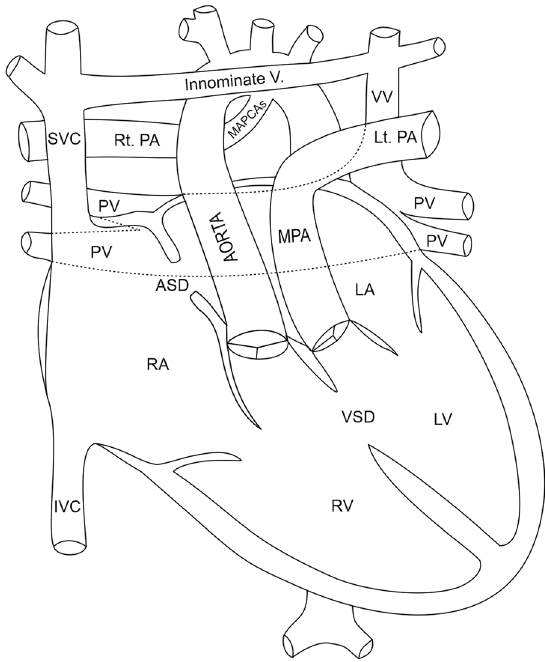
Fig. 3 Schematic of complex cardiac abnormalities of the reported case with the main feature of co-occurrence of D-TGA and supracardiac TAPVC. The right accessory pulmonary artery (Rt-PA) is supplied by arterial communication from the aorta, favoring major aortopulmonary collateral arteries (MAPCAs). Both ASD and VSD are present. ASD Atrial septal defect, IVC Inferior vena cava, LA Left atrium, Lt-PA Left pulmonary artery, LV Left ventricle, PV Pulmonary vein, RA Right atrium, RV Right ventricle, SVC Superior vena cava, VSD Ventricular septal